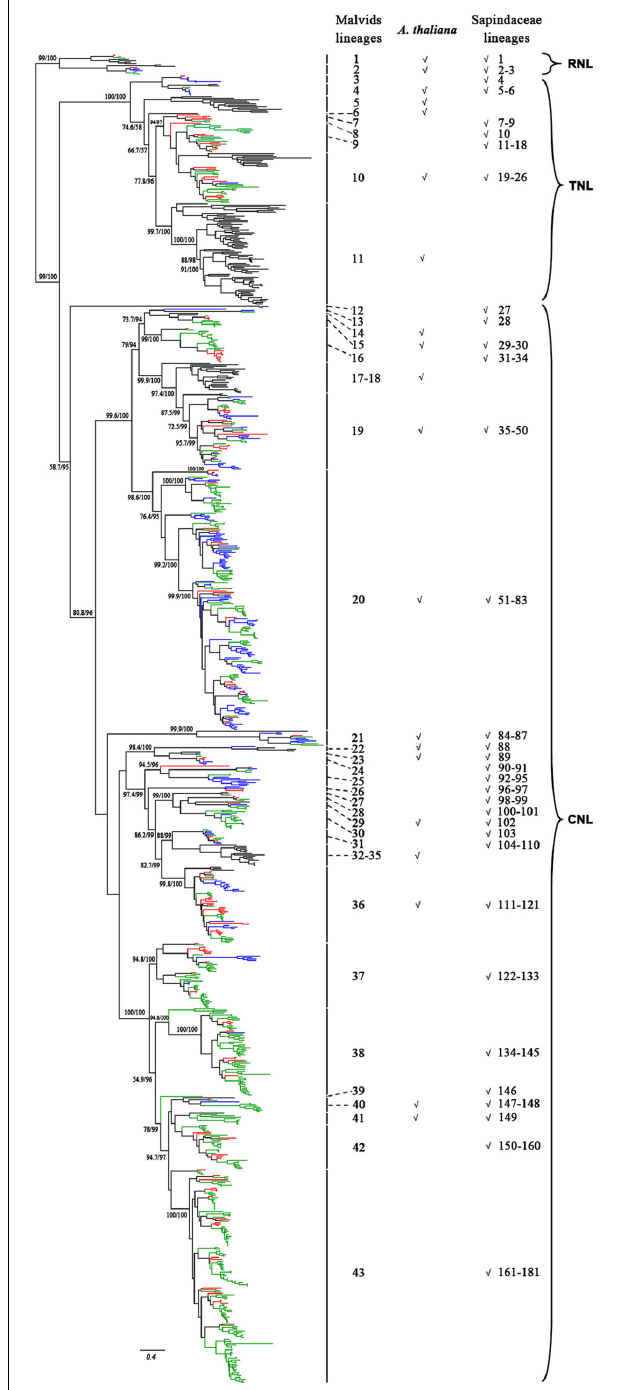
FIGURE 2 | Phylogenetic relationships of the NBS-encoding genes in X. sorbifolium , A. yangbiense , and D. longan based on the amino acids of conserved NBS domains. Red, blue, green, and black lines represent the NBS-encoding genes in X. sorbifolium , A. yangbiense , D. longan , and A. thaliana , respectively. Support values > 70% for basal nodes are shown. The reconstructed phylogeny was divided into 43 Malvids and 181 Sapindaceae lineage NBS-encoding genes. The first column number 1–43